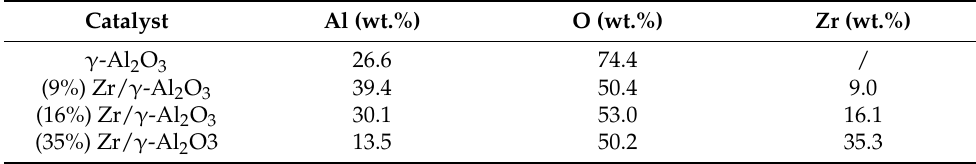
Table 1. Elemental composition of γ -Al 2 O 3 and Zr/ γ -Al 2 O 3 catalyst.